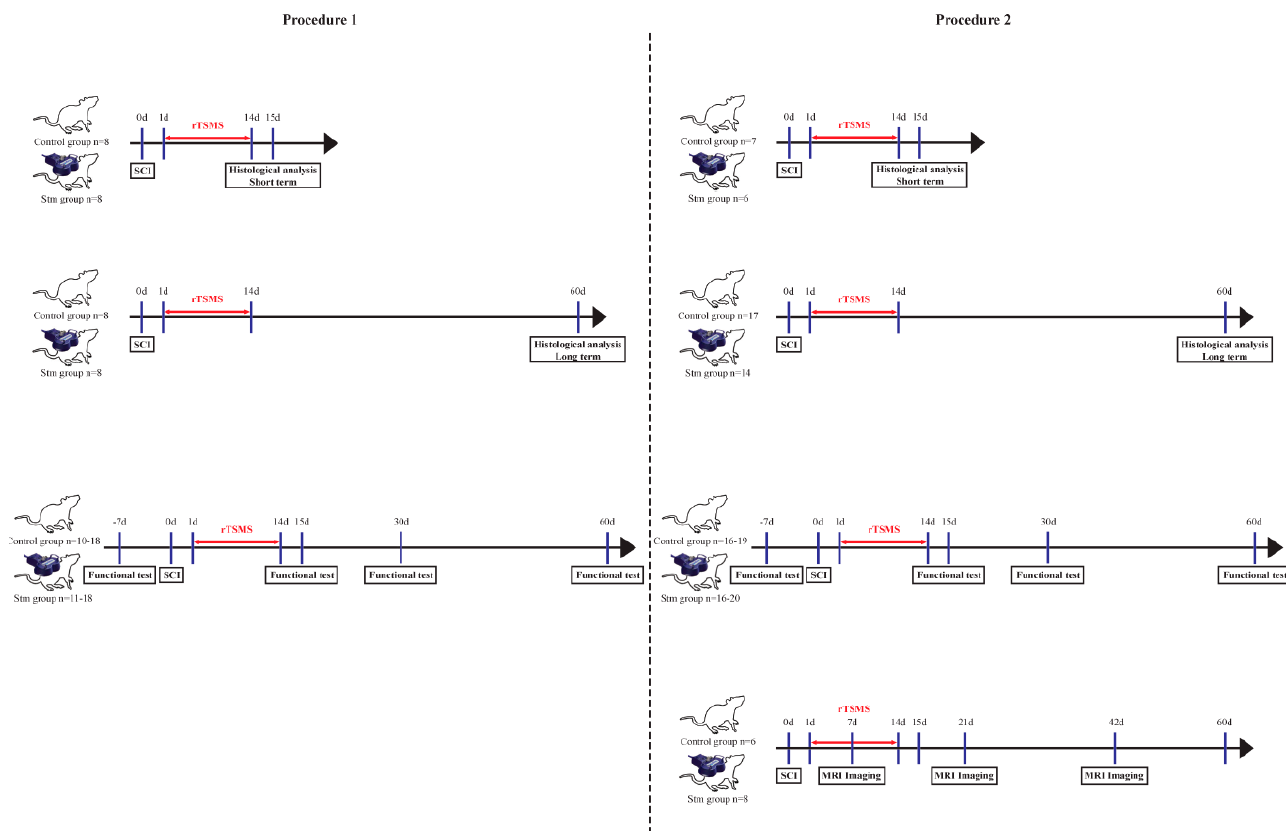
Figure 1. Experimental paradigms illustrating the timelines of the major experimental manipulations.